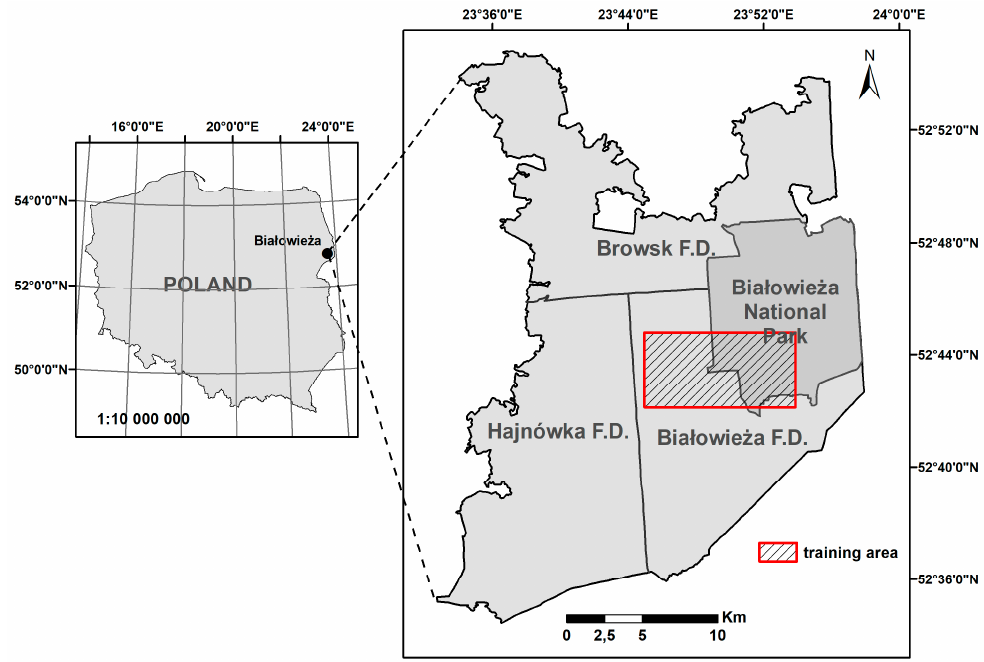
Figure 1. Research area—the Polish part of the Białowie˙za Forest with the training area marked in red.